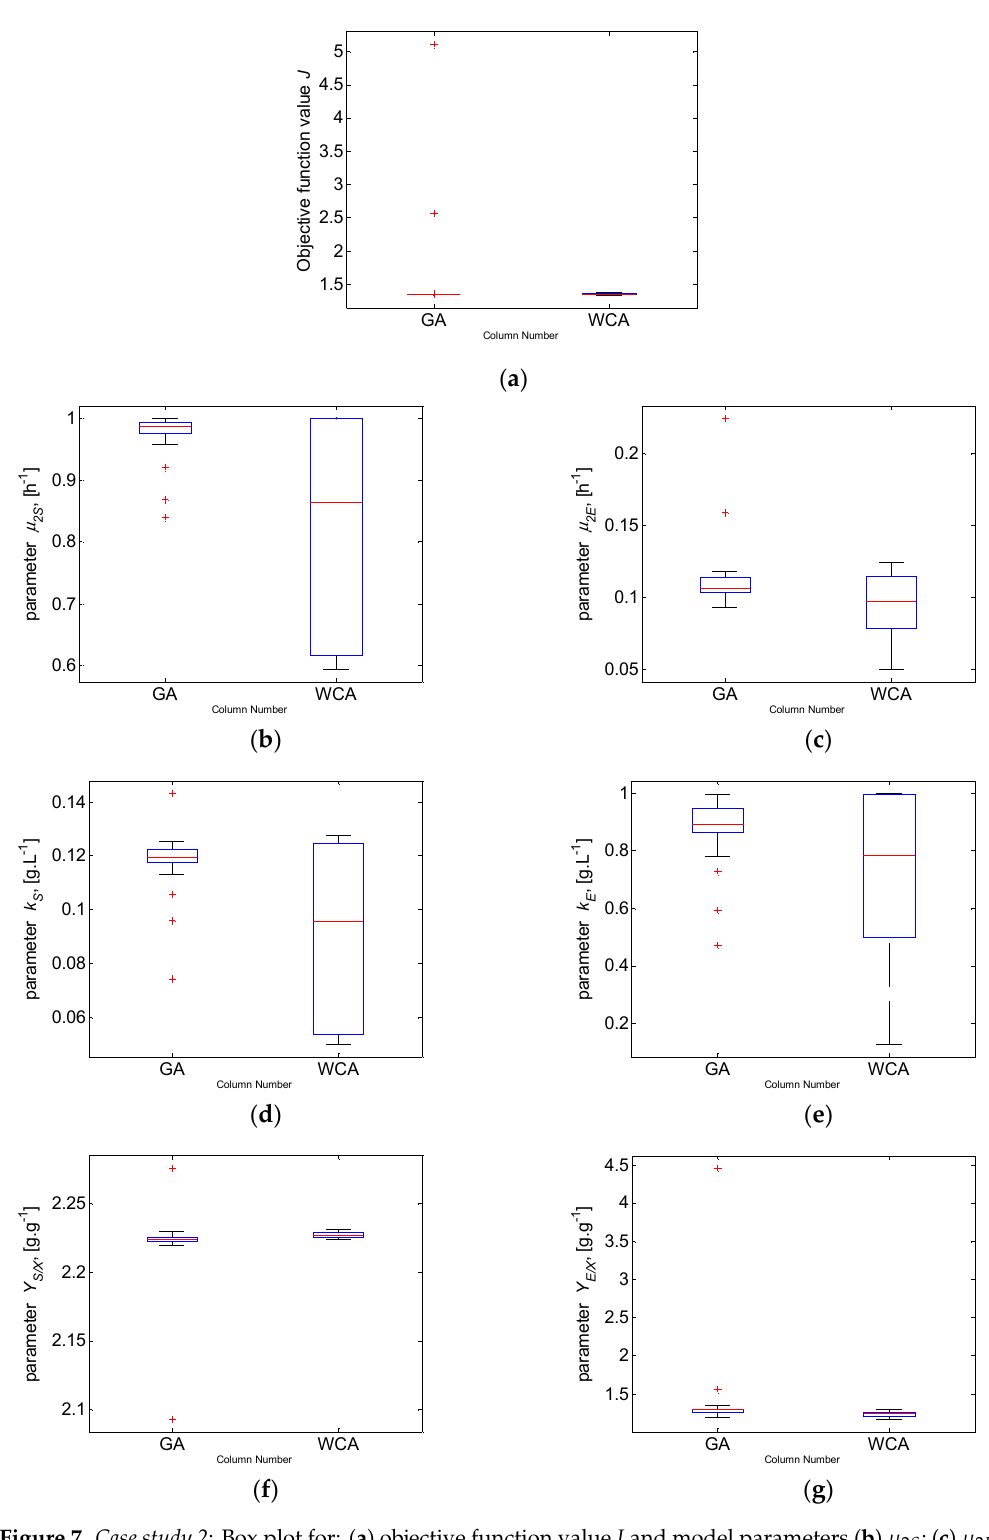
Figure 7. Case study 2 : Box plot for: ( a ) objective function value J and model parameters ( b ) µ 2 S ; ( c ) µ 2 E ; ( d ) k S ; ( e ) k E ; ( f ) Y S / X ; ( g ) Y E / X